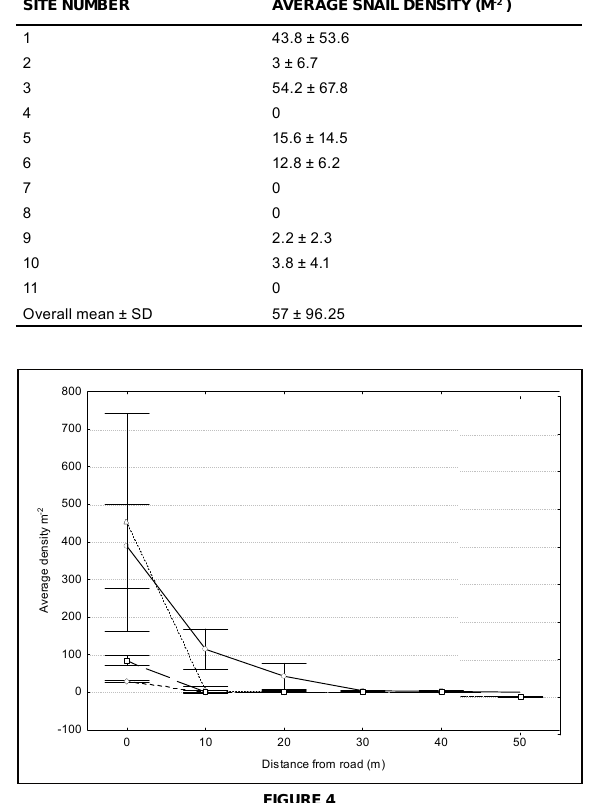
Figure 3 Dense population of Theba pisana at the bird hide in the WCNP